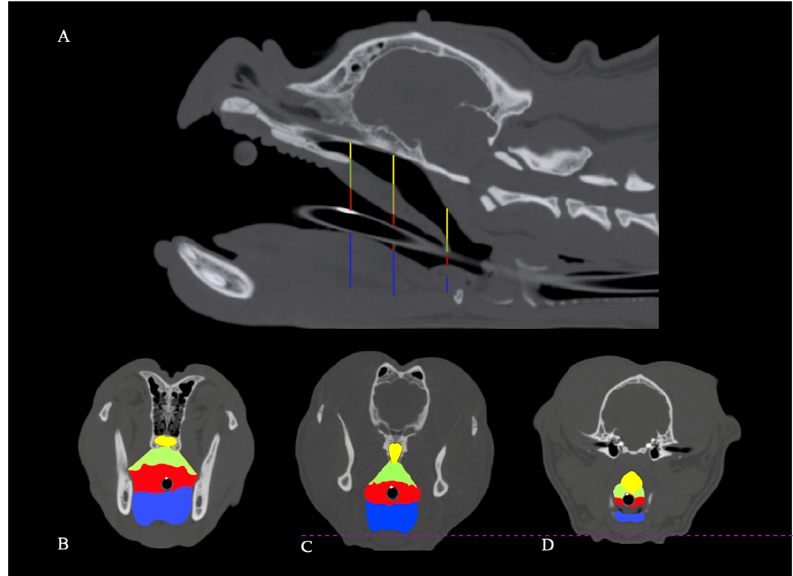
Figure 1. Computed tomography scans of an English bulldog skull. Vertical lines on the sagittal image of the skull ( A ) illustrate the position of corresponding transverse images of the same dog ( B – D ). B is located at the caudal tip of the hard palate, C is at the level of the last transverse slice with discernible humulae of the pterygoid bone, and D is positioned 5 slices cranial to the cranial tip of the basihyoid bone. Cross-sectional areas of the nasopharynx (yellow), soft palate (green), oropharynx (red; tracheal tube diameter not included), and the tongue (blue) are